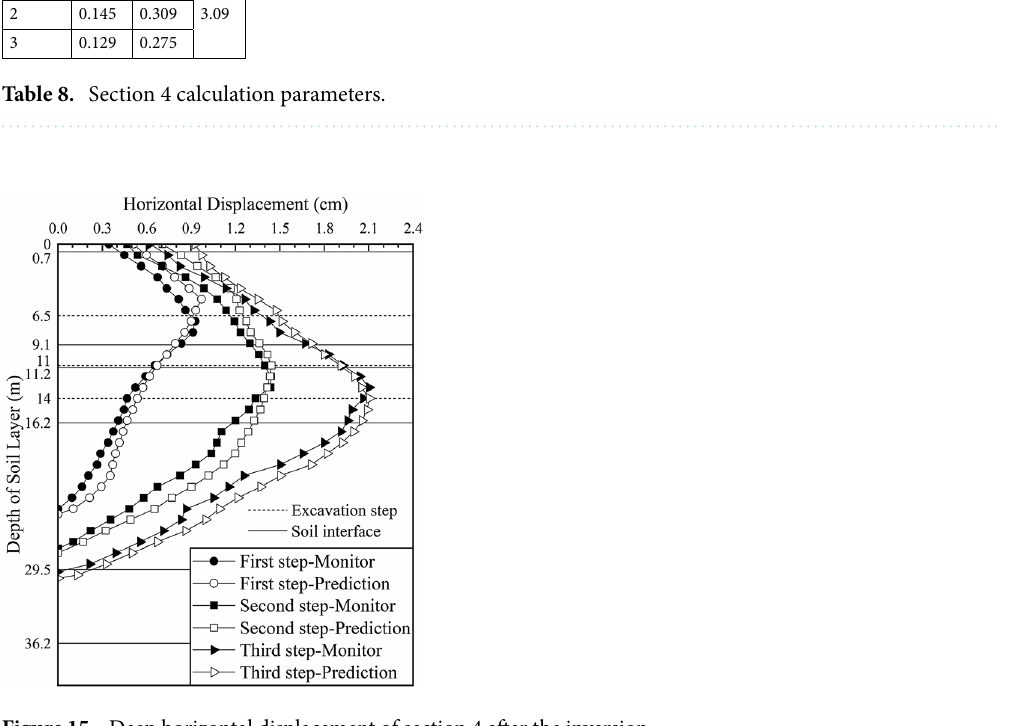
Figure 15. Deep horizontal displacement of section 4 after the